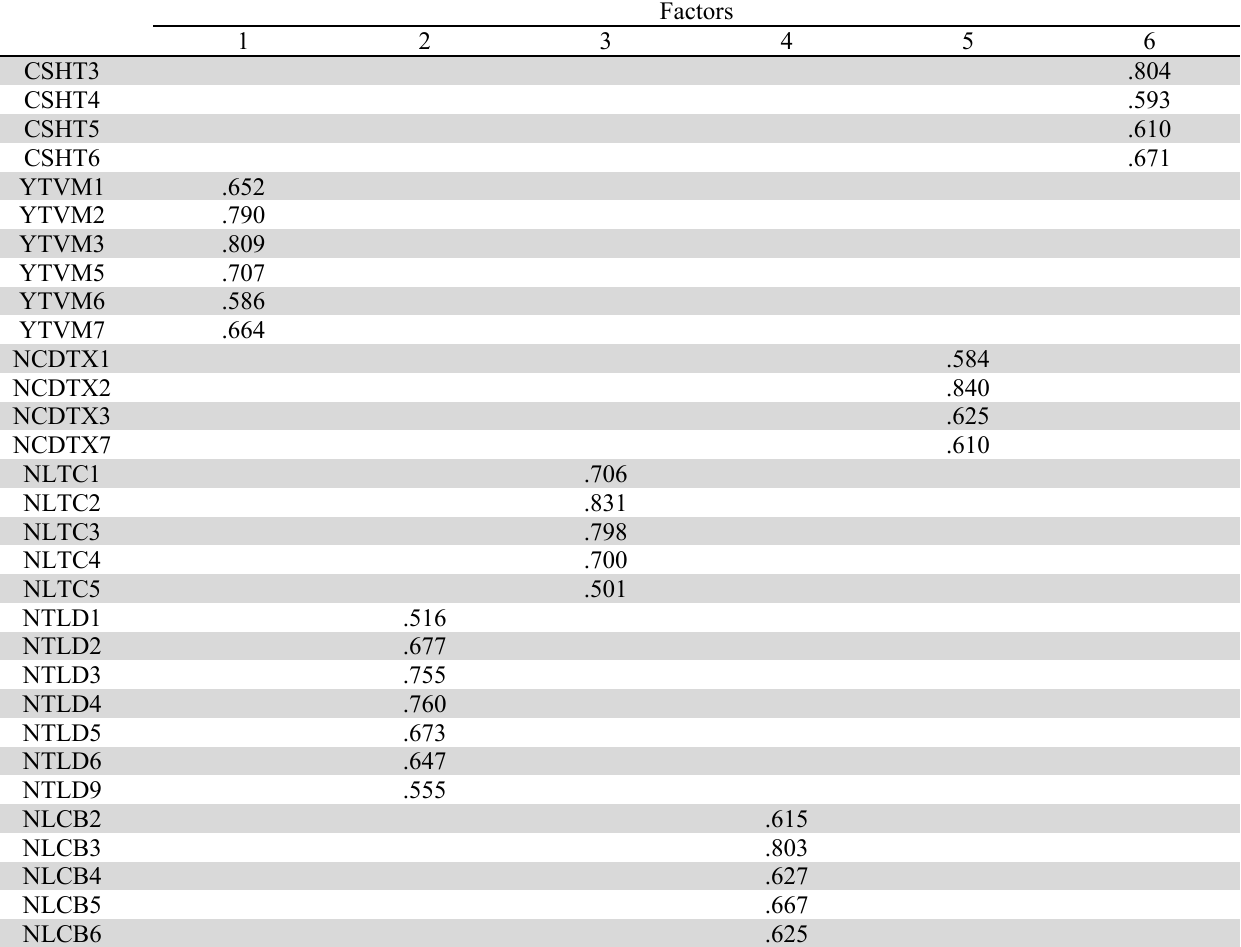
Rotation Component matrix for independent factors (11 th time)